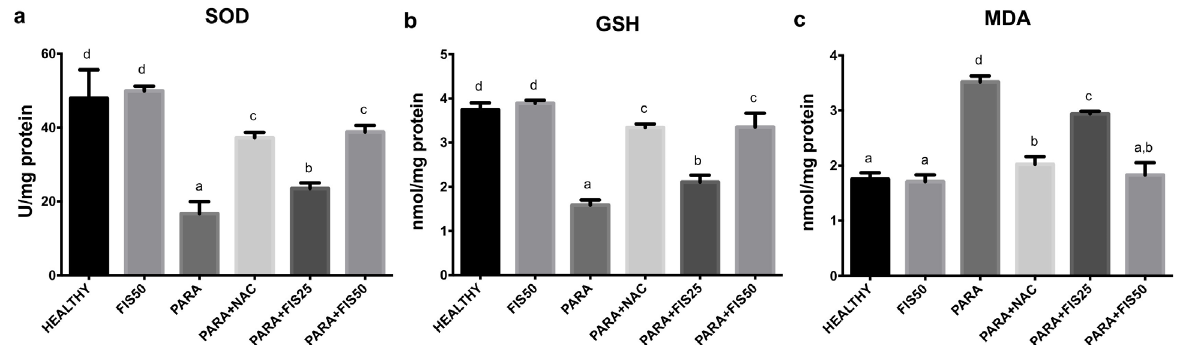
Figure 2. The Liver Tissue Oxidative Stress Results. a: SOD, b: GSH, c: MDA. Means with the same letter are not significantly different; means with different letters indicate significant differences between the groups according to the Duncan test (p < 0.05). Results are means ±